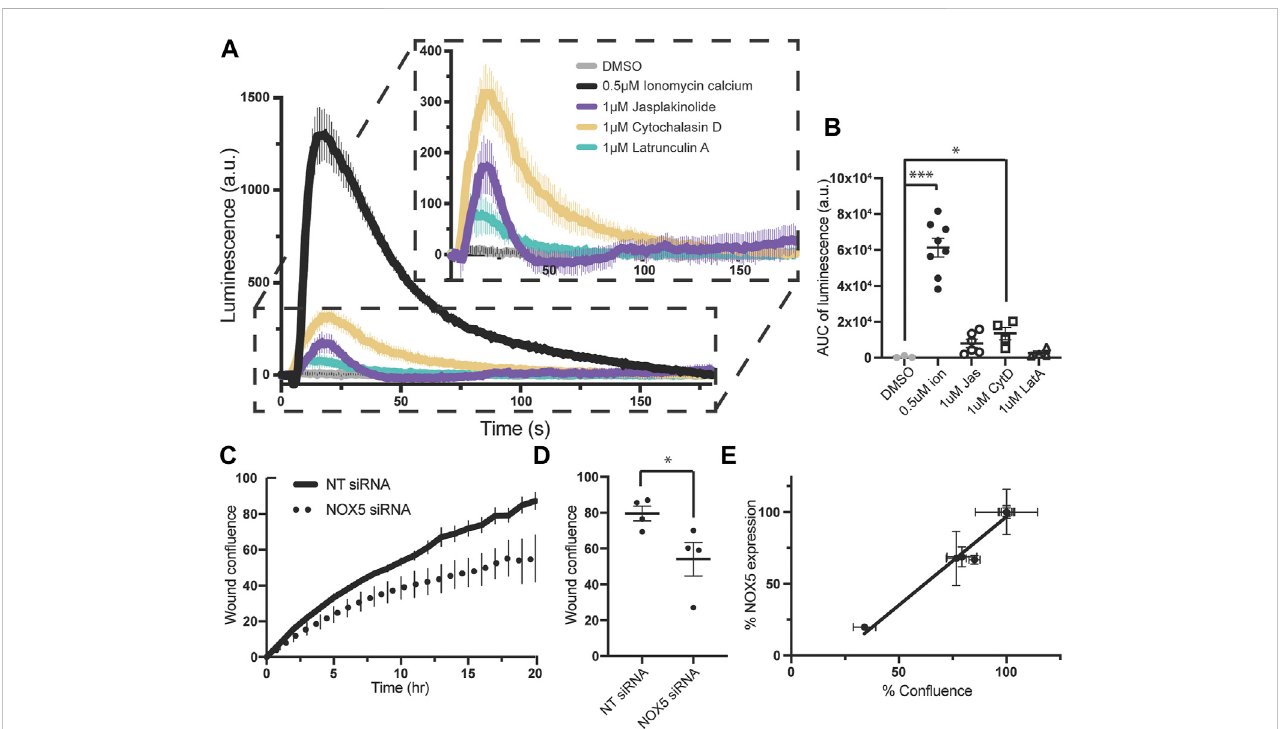
FIGURE 5 Superoxide production by endogenously expressed NOX5 in PSN-1 cells is stimulated by actin effector molecules and NOX5 knockdown by siRNA decreases PSN-1 cell migration. (A) Timecourse of superoxide production by PSN-1 cells after automated addition of DMSO, ionomycin calcium (0.5 μ M), jasplakinolide (1 μ M), cytochalasin D (1 μ M) or latrunculin A (1 μ M) and measured using L-012 luminescence. (B) Quanti fi cation of NOX5 superoxide production(areaunderthecurve).Valuesrepresentmeans±SEM, n =3 – 8.Differencesinsuperoxideproductionuponcompoundadditioncomparedto DMSO control were assessed using Student ’ s t -test with * denoting p < 0.05, and *** p < 0.0001. PSN-1 cells were transfected with non-targeting (NT) or NOX5 targeting siRNA and subjected to a scratch assay to measure cell migration. (C) Timecourse of wound con fl uence after scratch with quanti fi cation of wound con fl uence at 18 h shown in (D) . Values represent means ± SEM, n = 4. (E) Ef fi ciency of NOX5 knockdown by siRNA (NOX5 expression after transfection with NOX5 siRNA normalized to NT siRNA) plotted against % con fl uence at assay completion. Error bars re fl ect the technical replicates of each experiment with n = 2 – 3 for